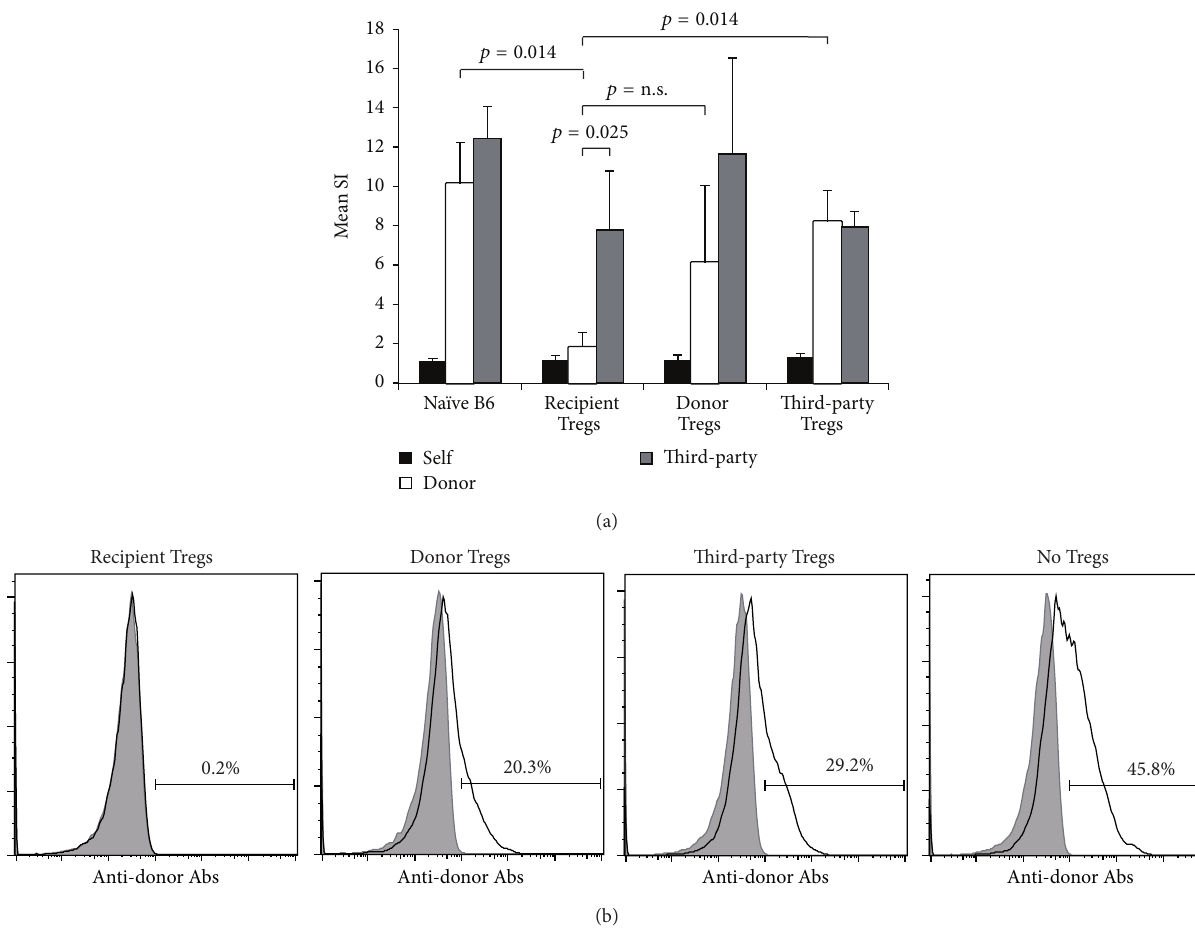
Figure 6: Chimeras induced through recipient Treg treatment demonstrate donor-specific hyporesponsiveness in vitro and humoral tolerance. (a) Mixed lymphocyte reaction results from selected BMT recipients were obtained 28–37 weeks after BMT. Chimeras of recipient Treg treated mice ( 𝑛 = 4 ) showed specific hyporesponsiveness to donor antigens in vitro ( 𝑝 = 0.0247 SI anti-donor compared to third-party antigen; 𝑝 = 0.0183 SI anti-donor compared to na¨ıve B6 mice, 𝑛 = 3 ). Donor reactivity was preserved in BMT recipients that were treated with donor ( 𝑛 = 3 ) or third-party ( 𝑛 = 3 ) type Tregs. SIs were calculated by dividing the mean cpm from responses against recipient (black column; B6), donor (white column; Balb/c), or third-party (grey column; C3H) stimulator cells by mean background cpm (i.e., cpm with no stimulator population). Error bars indicate standard deviation. (b) BMT recipients were analyzed for the existence of anti-donor antibodies in serum > 3 months after BMT (i.e. ∼ 1-2 months after skin grafting). Recipient Treg induced chimeras ( 𝑛 = 4 ) uniformly failed to develop detectable levels of anti-donor antibodies, whereas BMT recipients treated with donor ( 𝑛 = 4 ) or third-party ( 𝑛 = 3 ) Tregs and control mice without Treg treatment (but receiving BM, costimulation blockade, and rapamycin; 𝑛 = 5 ) developed substantial antibody levels. The reactivity of sera with syngeneic (B6; grey filled area) and donor (Balb/c; black line) thymocytes is shown by flow cytometry through indirect staining with anti-mouse IgG. Representative histograms are